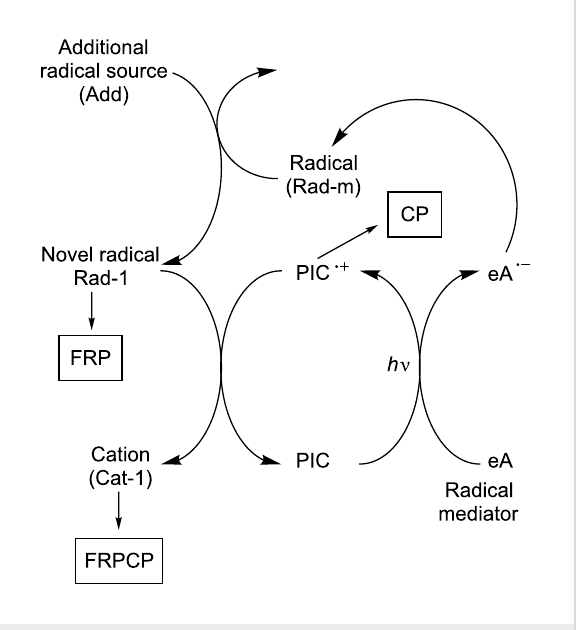
Scheme 4: Reaction mechanisms for the system